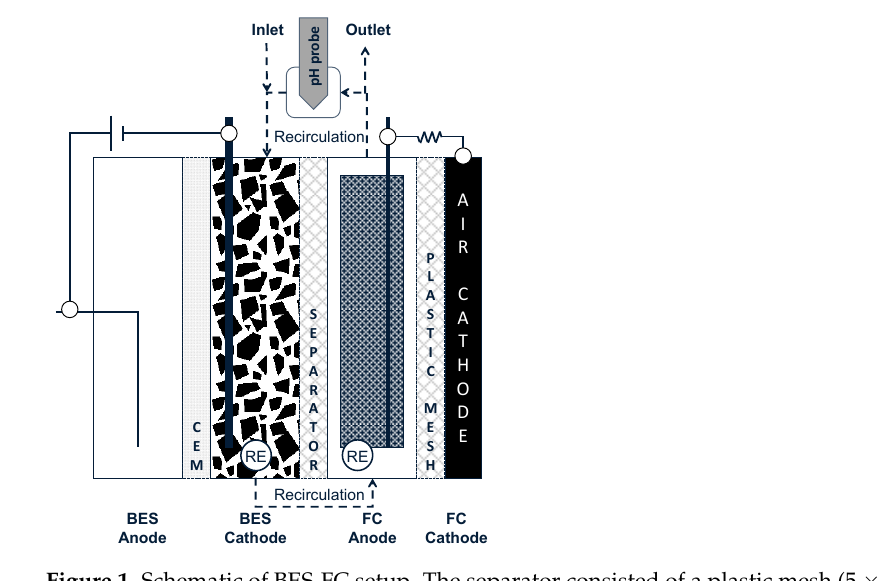
Figure 1. Schematic of BES-FC setup. The separator consisted of a plastic mesh (5 × 5 mm 2 of grid and 1 mm of thickness). It was replaced by rubber after 145 days of operation. CEM: cation-exchange membrane, RE: reference electrode.